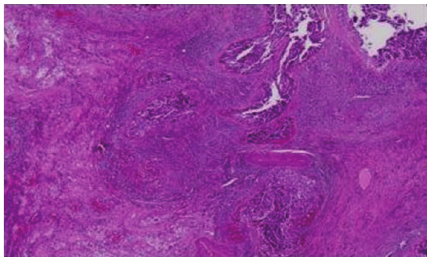
Figure 1: Embryonal cell carcinoma of the right testis.